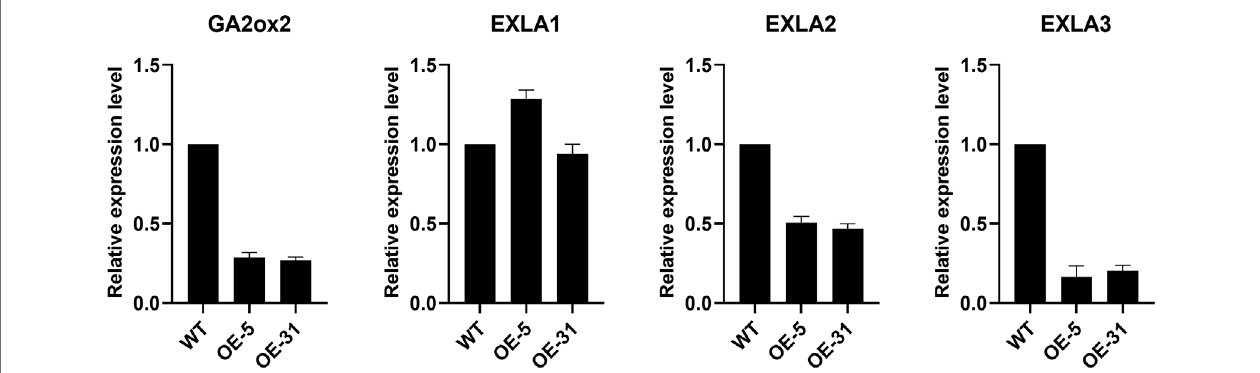
FIGURE 8 | Expression levels of the root development genes. Relative expression levels of GA2ox2 , EXLA1 EXLA2 , and EXLA3 in 5-day-old seedlings. The error bars represent the means of three technical replicates